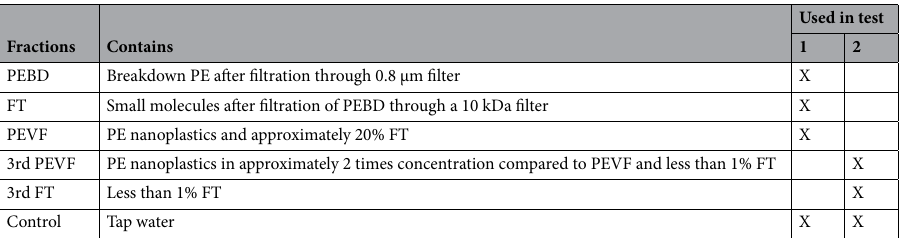
Table 2. The different fractions from PE breakdown and in which toxicity test they are used.